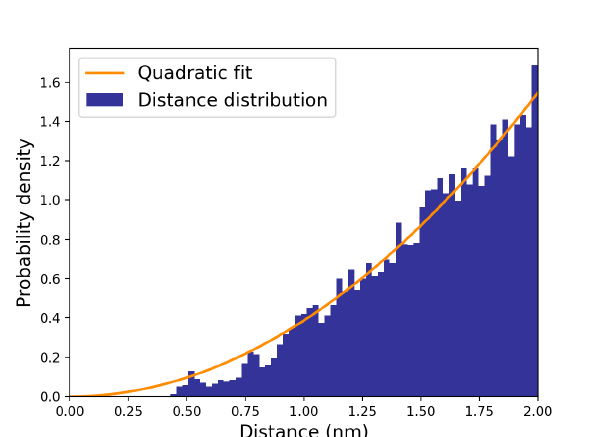
Figure 6. Distribution of hydroxide ion–dineopentyl phosphate distance (navy); quadratic fitting function of the distance distribution (orange).